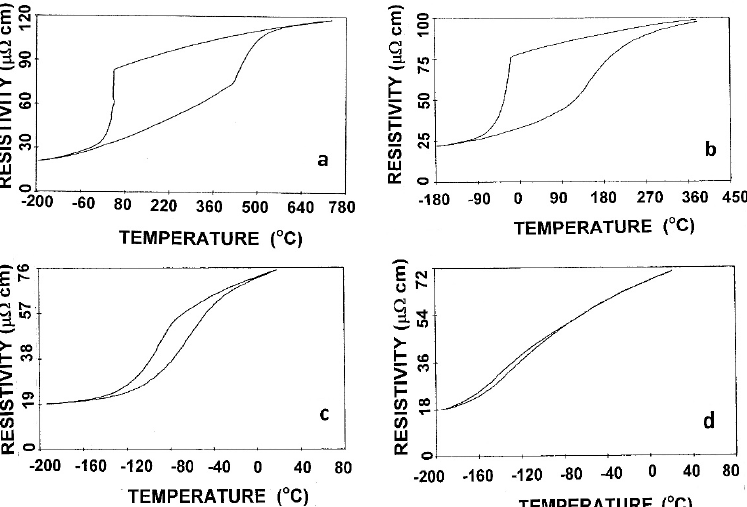
Figure 3. Resistivity versus temperature curves for the martensitic transformation in Fe-24 at. % Pt alloy: for disordered alloy ( a ); after ordering at 550 °C for 10 h ( b ); for 100 h ( c ); and for 1050 h ( d ). Note that the temperature and resistivity scales vary. After [11].